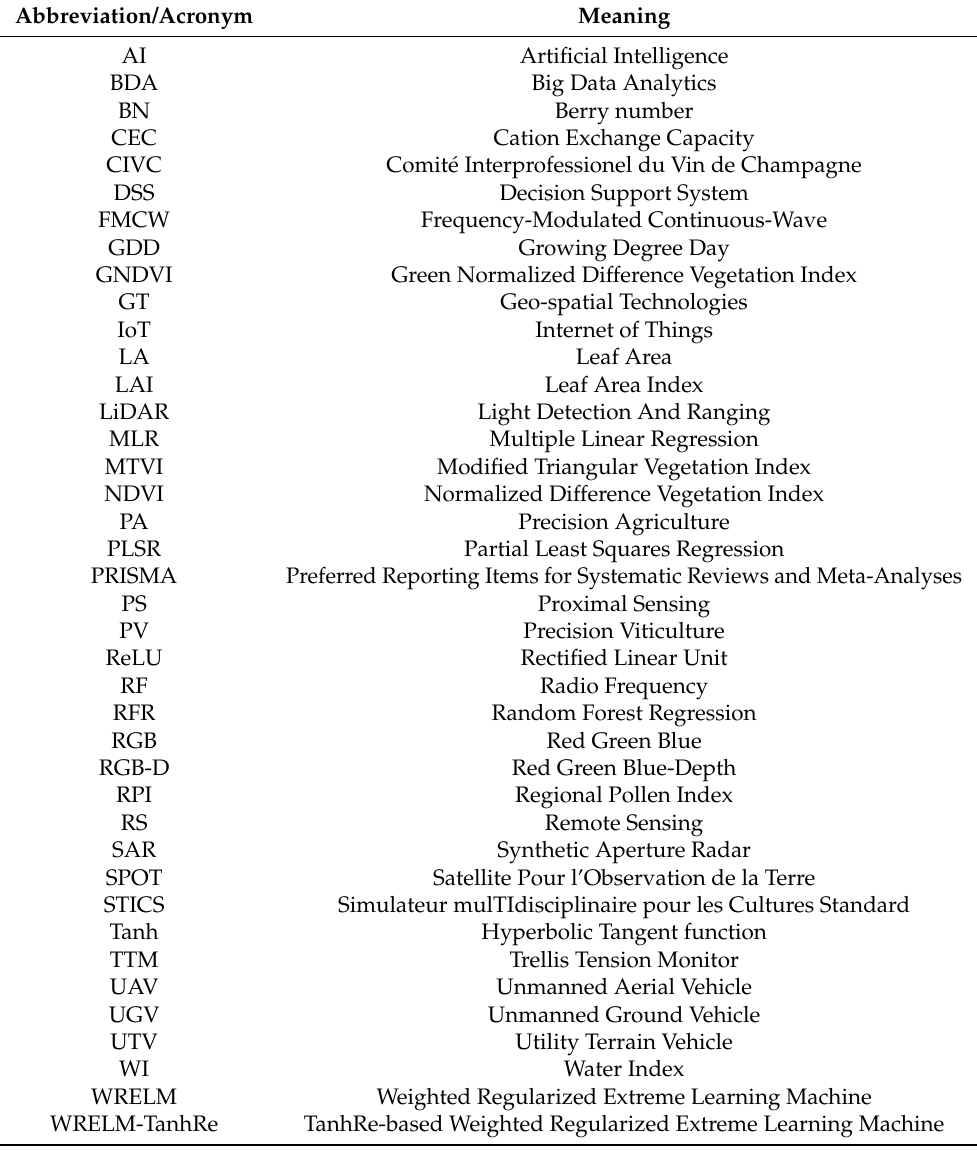
Table 1. List of abbreviations and